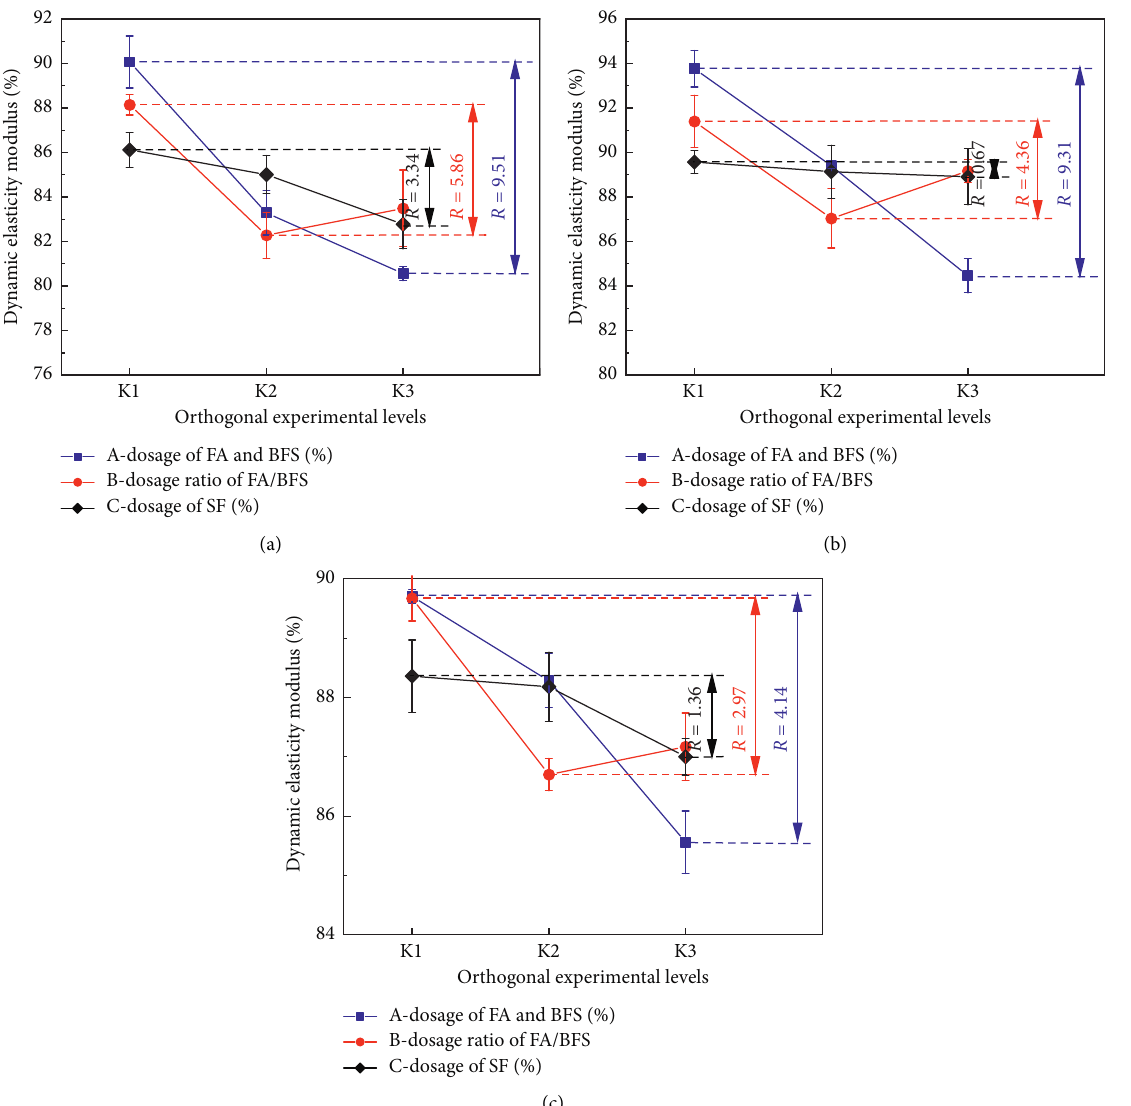
Figure 8: Range analysis between relative dynamic elasticity modulus and orthogonal experimental levels of cement concrete. (a) Air content of (2.5 ± 0.5)%. (b) Air content of (4.5 ± 0.5)%. (c) Air content of (6.5 ±